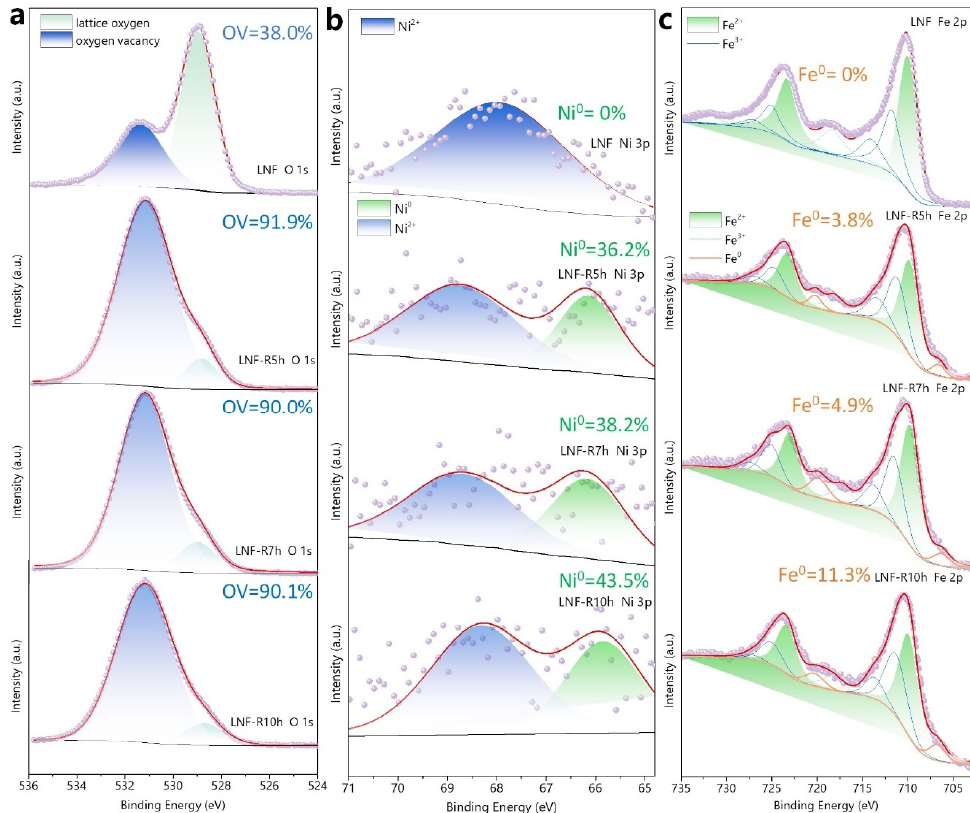
Figure 3. XPS analysis of the LNF samples ( a ) O 1s, ( b ) Ni 3p, and ( c ) Fe 2p for each sample. The oxidation states of the nickel were estimated from the evolution of Ni 3p species (Figure 3b). The peaks appeared at 66.0 and 67.5 eV (green- and blue-shaded areas), which are the typical 3p binding energies for Ni 0 and Ni 2+ in oxides, respectively [26]. In the pris- tine LNF, Ni 2+ was the main peak. As the reduction time increased from 5 to 7 to 10 h, the Ni 0 fraction increased from 36.2% to 38.2% to 43.5%, respectively; this change indicated that, as the reduction time increased, more nickel oxide was reduced to metal. A similar tendency for Ni exsolution has previously been reported [26]. This indicates that the nickel in the LNF bulk lattice continuously exsolves to the surface under the reducing environment. In the Fe 2p binding energy analysis (Figure 3c), peaks were detected at 709.6 and 711.4 eV, which were assigned to Fe 2+ and Fe 3+ , respectively [27,29,30]. The Fe 2+ fractions for LNF–R5, LNF–R7, and LNF–R10 are 51.1%, 55.8%, and 57.9%, respectively, which in- dicates the partial reduction of lattice Fe 3+ during exsolution treatment. The increasing Fe 2+ fractions results in unit cell volume expansion, and, thus, explains why, in Figure 1b, the metal XRD peak shifted to a lower 2 θ . The fraction of Fe metal was 0% for pristine LNF, but the Fe metal peak appeared after the reduction treatment, and as the reduction time increased from 5 to 7 to 10 h, the Fe fraction increased from 3.8% to 4.9% to 11.3%, respec- tively. This concurs with the results of the XRD and TEM–EDS analyses, which demon- strated that a small amount of Fe was reduced to Fe 0 with the reduction treatment, and, on increasing the reduction time, the amount of reduced metals was slightly increased. The XRD, SEM, TEM, and XPS results led to the following two observations: firstly, with the reduction treatment, Ni metal segregates from the bulk lattice, and emerges on the surface to form NPs, without changing the parent perovskite structure; secondly, if the